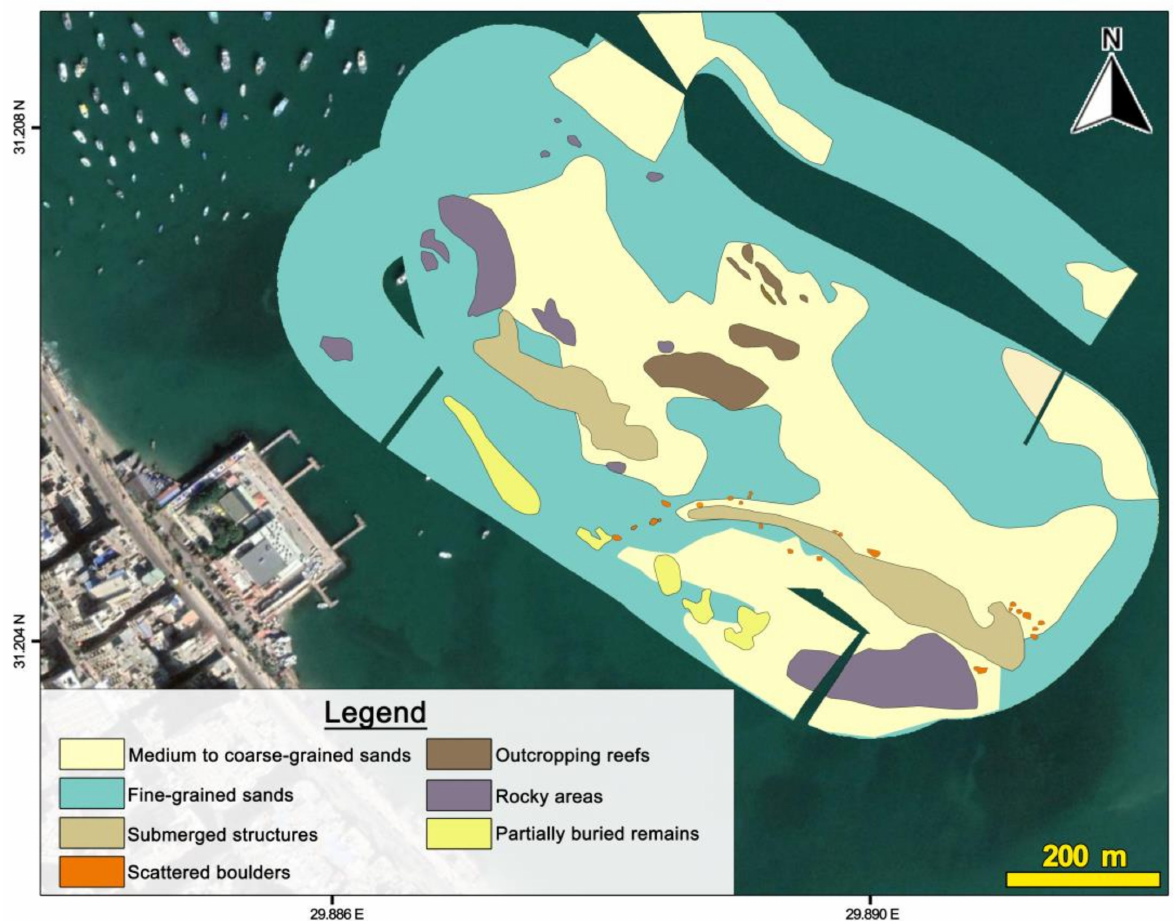
Figure 14. Synthetic classification map resulted from combining the mosaic image with the sediment classification